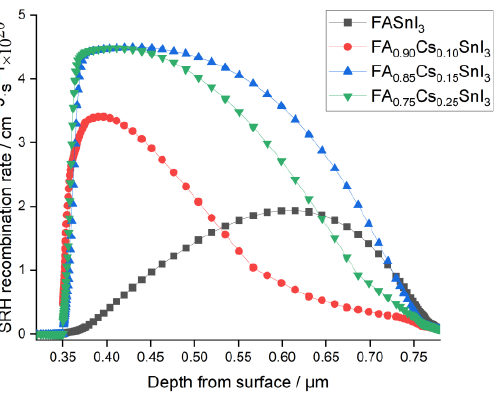
Figure 4. Effect of the Cs content in the absorber with TiO 2 ETL on the recombination rate with depth from the surface.